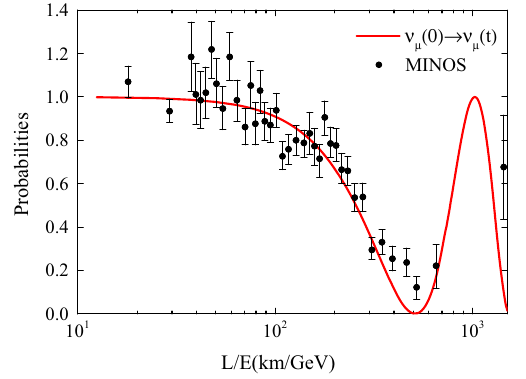
Fig. 4 The long-range survival probability ν μ → ν μ (solid line, red) versus the ratio L / E with the initial muon flavor state. The solid line is theoretical value and the data of the MINOS Collaboration (black circle) taken from Ref. [19]